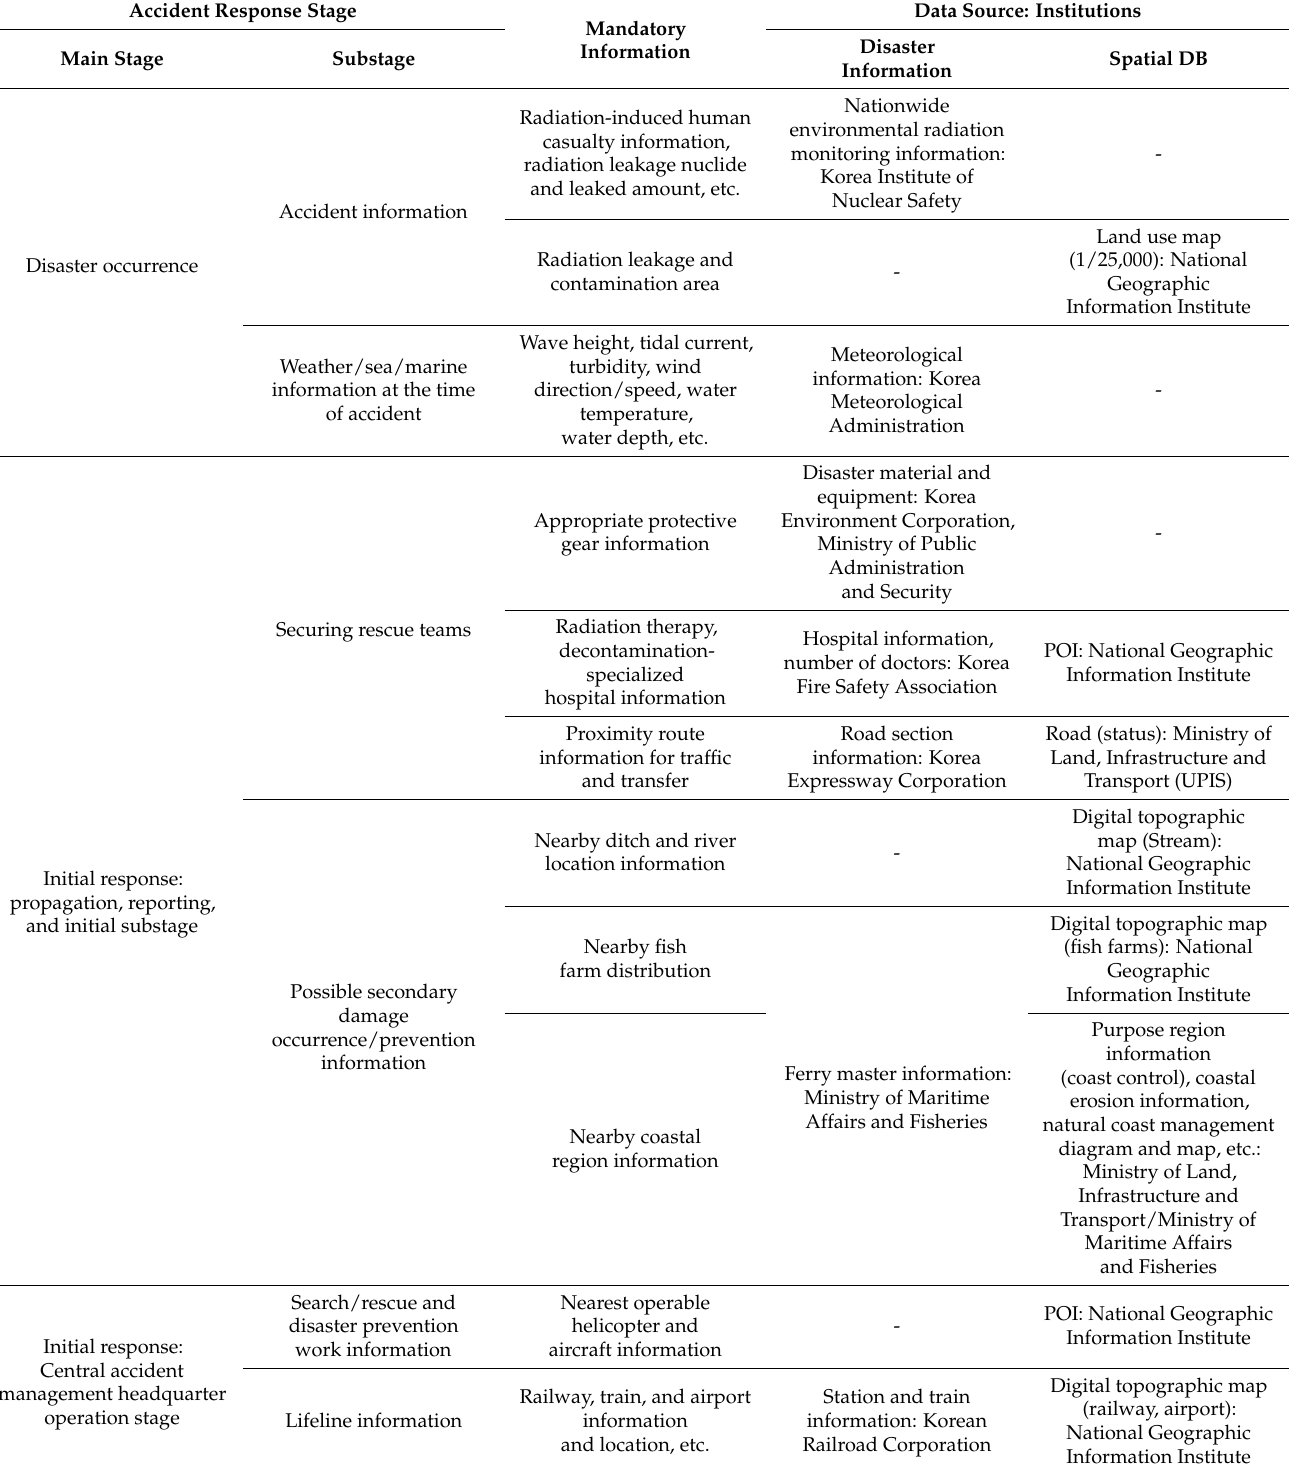
Table 8. Example of combination of spatial data with disaster information (e.g., nuclear power plant